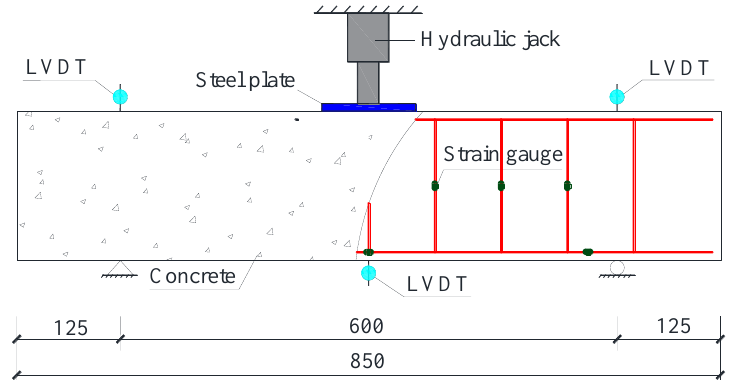
Figure 3. Test apparatus for specimens C-2 (units: mm).